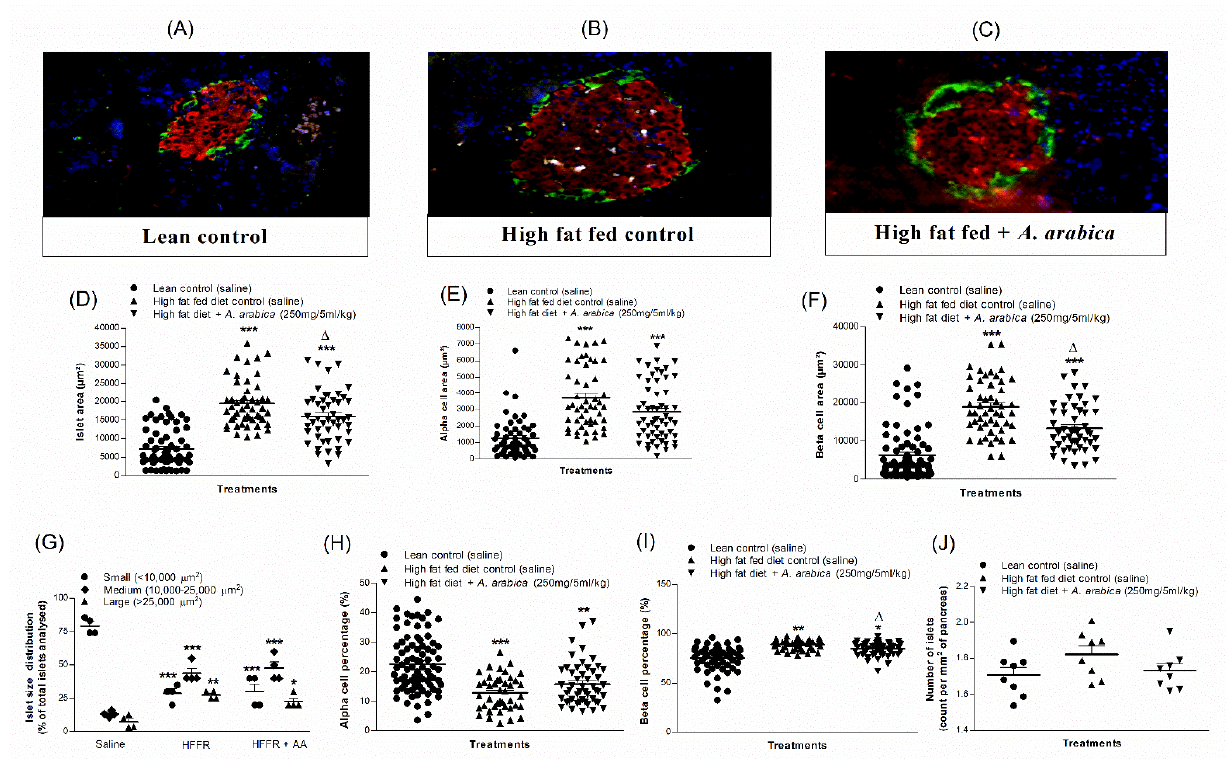
Figure 6. Effects of 9-day twice-daily oral administration of hot-water extract of A. arabica bark on islet morphology in high-fat-fed rats. Representative images of ( A ) lean control, ( B ) high-fat-fed control and ( C ) high-fat-fed plus hot-water extract of A. arabica (250 mg/5 mL/kg) in rats showing insulin in red, glucagon in green and DAPI in blue, ( D ) islet area, ( E ) alpha-cell area, ( F ) beta-cell area, ( G ) islet size distribution, ( H ) alpha-cell percentage, ( I ) beta-cell percentage and ( J ) number of islets (per mm 2 ), respectively. Values are the mean ± SEM for n = 8 (~50 islets per group). * p < 0.05, ** p < 0.01 and *** p < 0.001 compared to lean control. Δ p < 0.05 compared to high fat fed alone (control).